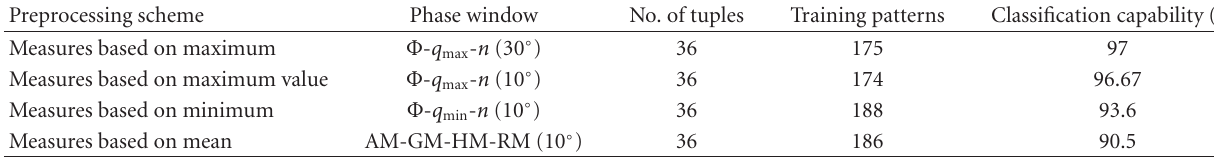
Table 9: Classification capability of HGPNN for multiple source PD